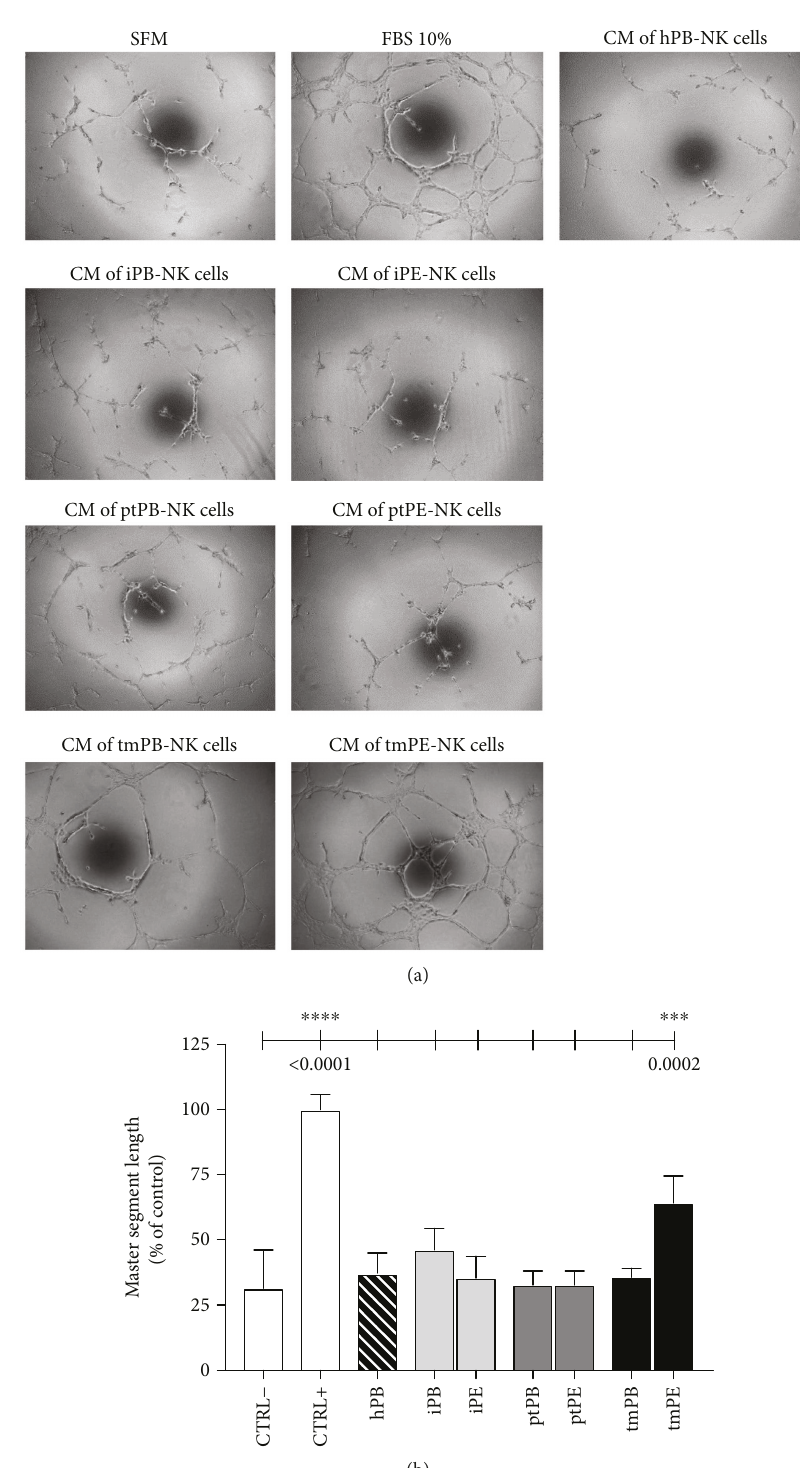
Figure 8: Evaluation of NK cell-derived supernatants ’ ability to induce morphogenesis on endothelial cells. Following 6h exposition with NK cell-derived supernatants, tmPE-NK samples showed a signi fi cantly higher ability to induce the formation of capillary-like structures on HUVECs seeded on matrigel-precoated plates compared with samples derived from iPE-NK or ptPE-NK cells. Negative control (CTRL − ) consisted in FBS-free Endothelial Basal Medium-2 (EBM, Lonza); positive controls (CTRL+) consisted in Endothelial Growth Medium-2 (EGM-2, Lonza), supplemented with bullet-kit (VEGF, FGF1, FGF2, insulin, hydrocortisone, and heparin; Lonza) containing 10% of FBS. Microphotographs (a) were taken at 10x magni fi cation, and master segment lengths (b) were quanti fi ed by the Angiogenesis Analyzer ImageJ tool kit. Data are shown as mean ± SEM; ∗∗∗ p < 0 001 and ∗∗∗∗ p < 0 0001 ( p values are